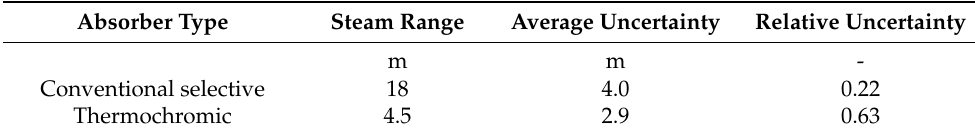
Table 4. Relative uncertainty to be used in system